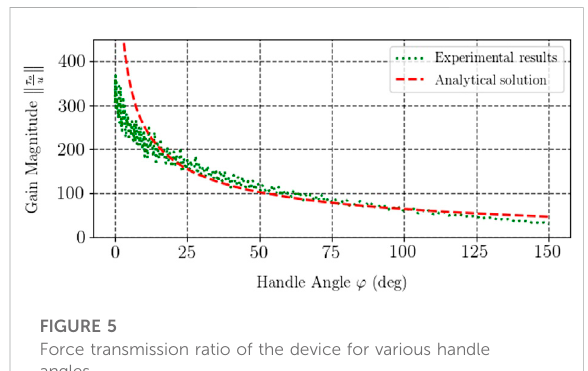
FIGURE 5 Force transmission ratio of the device for various handle